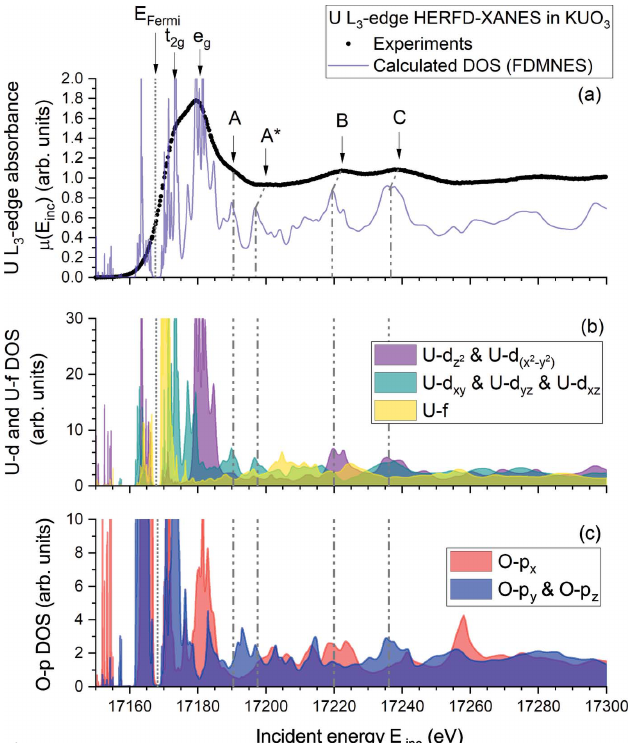
Figure 3 ( a ) Uranium L 3 -edge HERFD-XANES and the corresponding simulated spectrum using FDMNES . ( b , c ) Calculated U- d , U- f and O- p partial DOS, here expressed as cubic harmonics (except U- f ), to allow direct comparison with the experimental XANES spectrum. The Fermi energy level is indicated with a vertical dotted line. Vertical dashed-dotted lines indicating the position of features A, A ? , B and C in partial DOS are also present to guide the eyes. We refer to Figure 6 of the supporting information for the other calculated partial DOS.